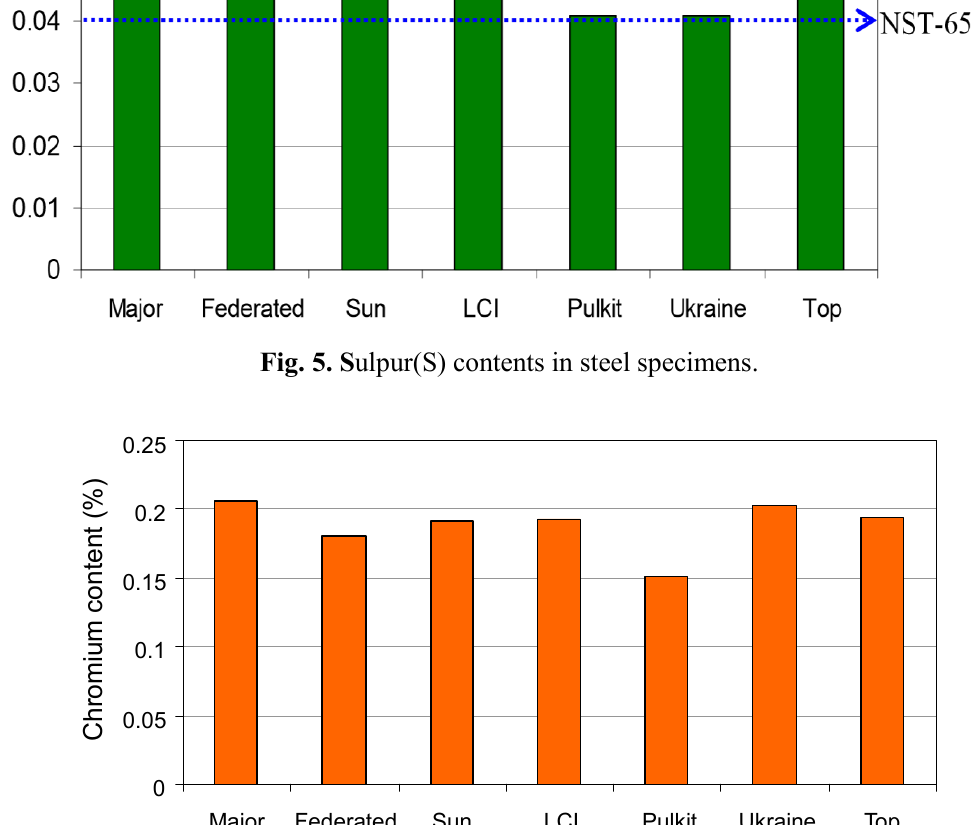
Fig. 4. P hosphorous (P) contents in steel specimens.